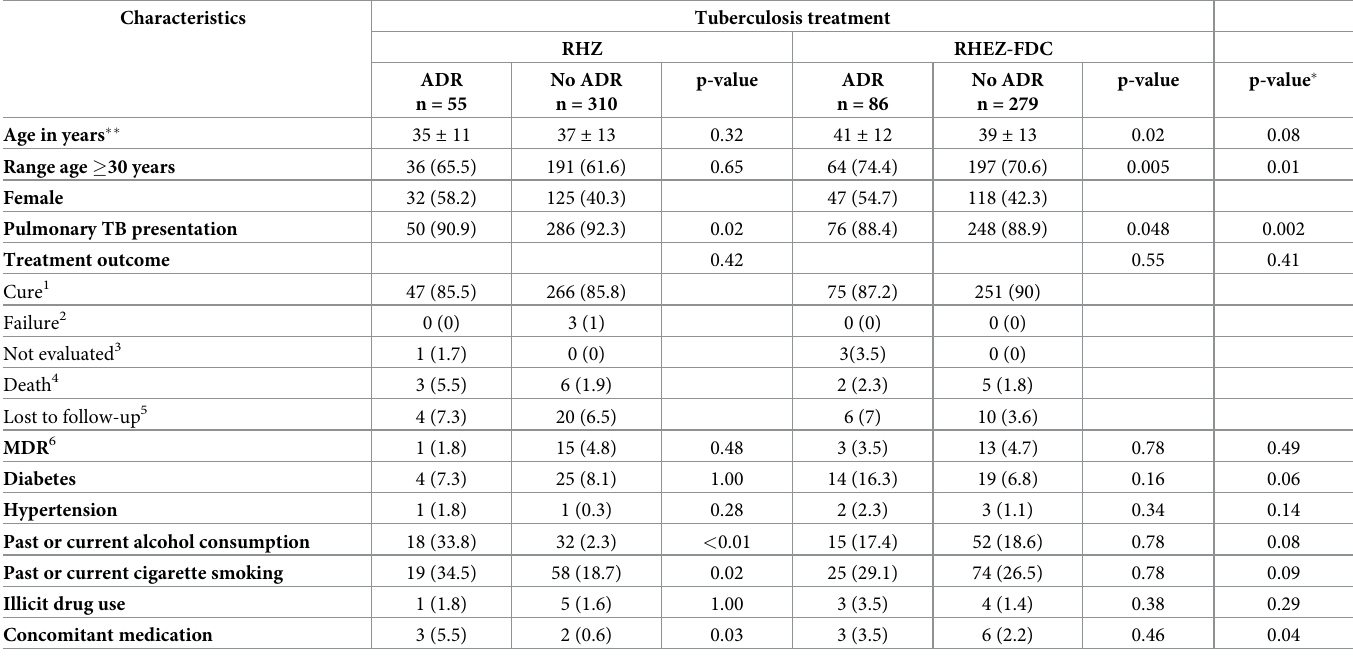
Table 3. Treatment outcome and sputum smear result of tuberculosis patients.